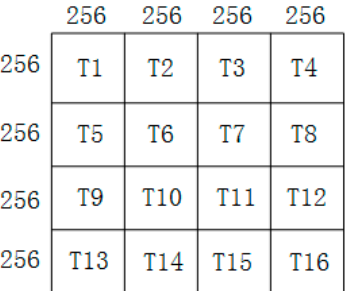
Figure 7. Block threshold segmentation.